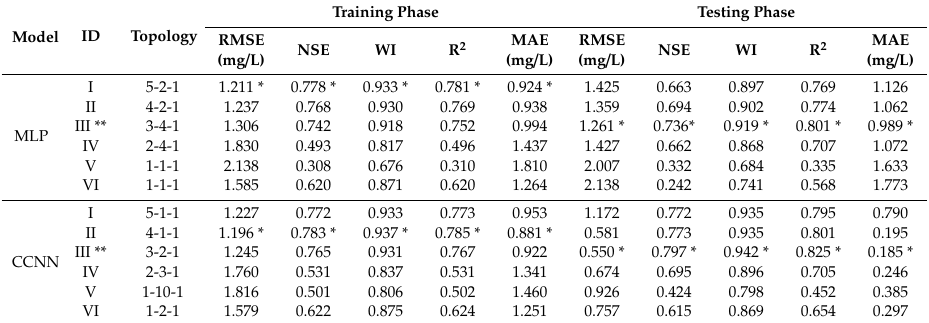
Table 3. Performance statistics of various input combination using MLP and CCNN models.